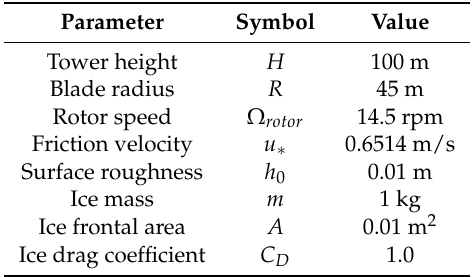
Table 1. Summary of the case set-up for 3DOF object